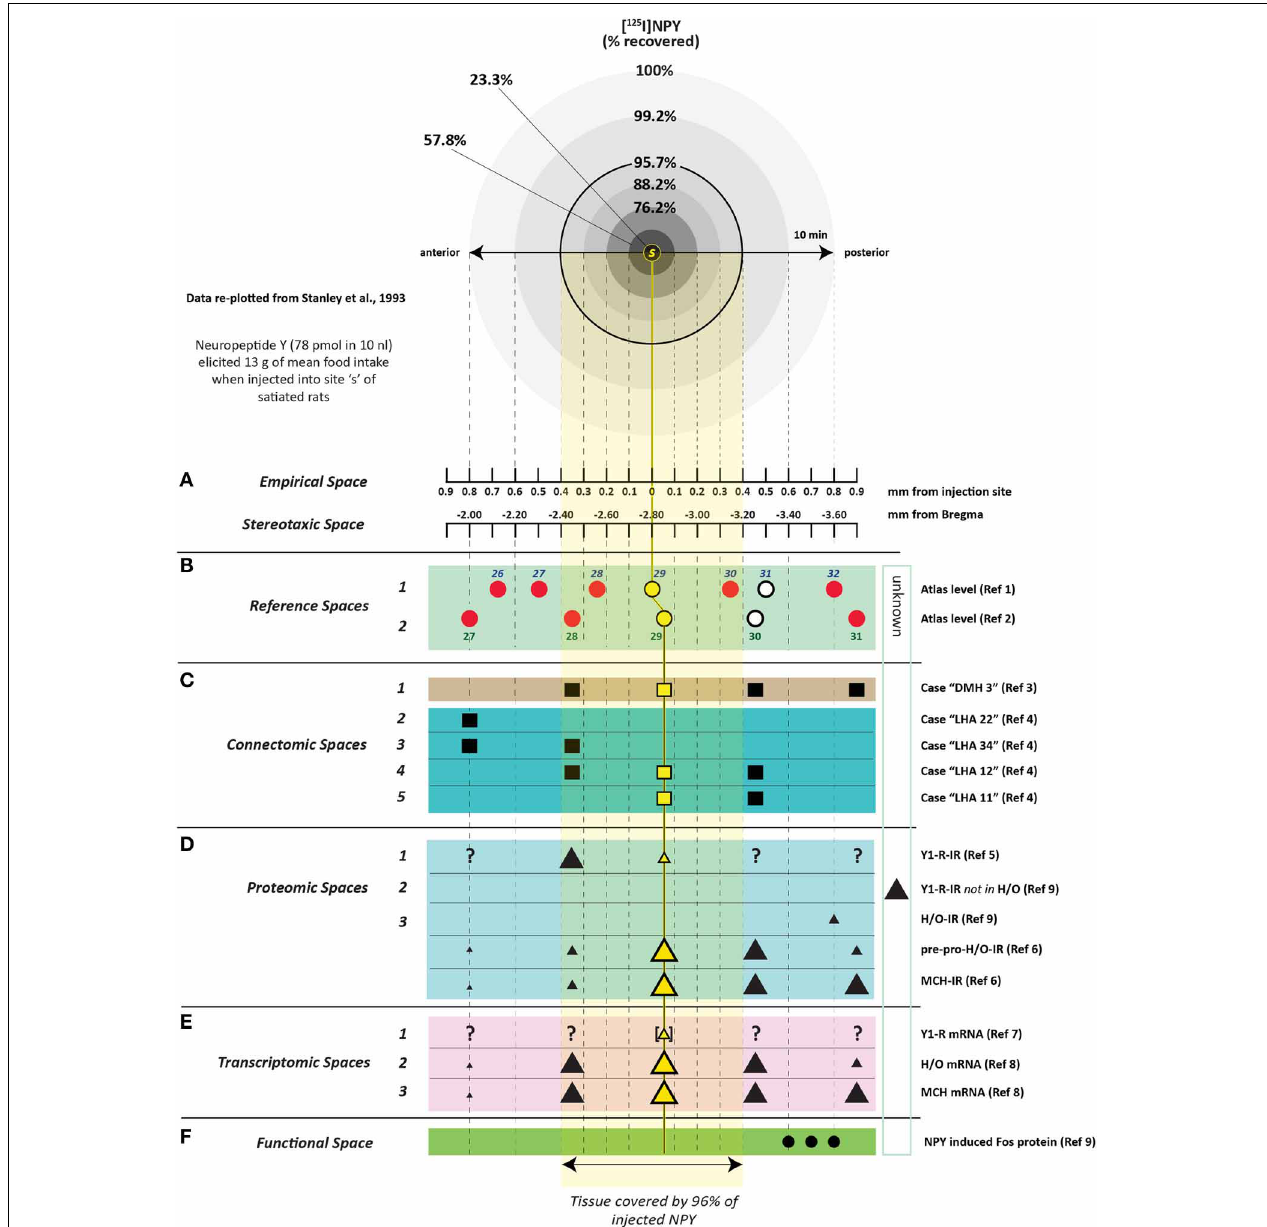
FIGURE 9 | An example of how visualizable spaces can be aligned to help identify neural substrates underlying feeding triggered by an injection of neuropeptide Y. Data in the radial spread at the top of the figure are derived from the diffusion data of Stanley et al. (1993b) shown in Figure 3 in this article. The distance traveled by the diffusing solution of injected radiolabeled neuropeptide Y, is noted along a millimeter axis representing Empirical Space (A) . This space, in turn, is aligned with Stereotaxic Space (also panel A ), and then aligned with (B) Reference Space 1 (Paxinos and Watson, 1986) and Reference Space 2 (Swanson, 2004). Alignment to these